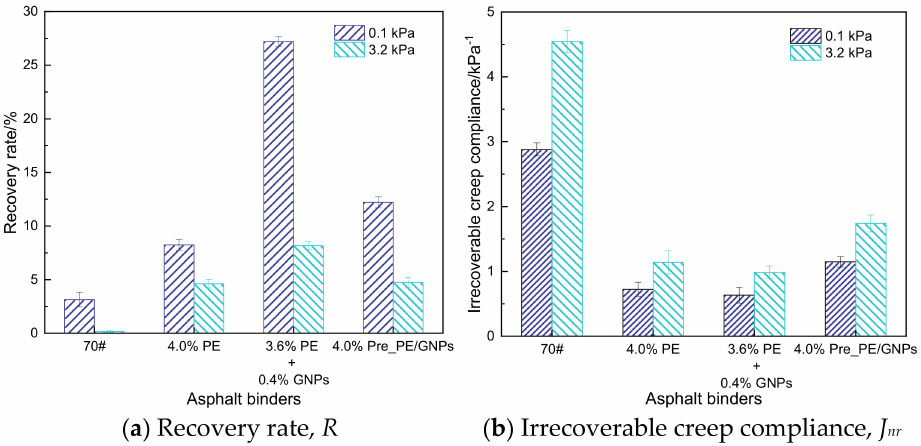
Figure 6. Test parameters of multiple stress creep recovery of asphalt binders. ( a ) Recovery rate, R , ( b ) Irrecoverable creep compliance, J nr